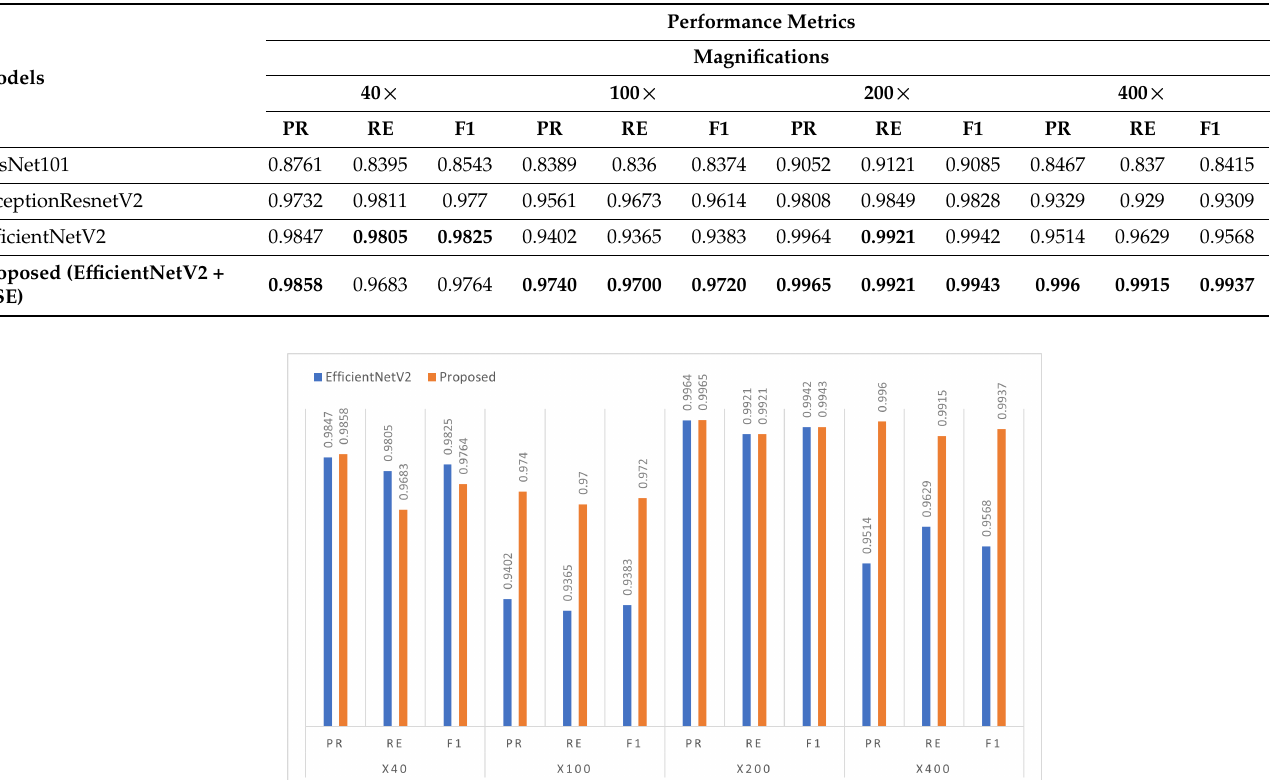
Table 2. Classification performance of the proposed model compared with three state-of-the-art diagnoses of breast cancer benign and malignant types in histopathology images. Note that ‘PR’ stands for ‘Precision’, ‘RE’ stands for ‘Recall’, and ‘F1’ represents the ‘F1-score’. The best significant result is highlighted in bold.